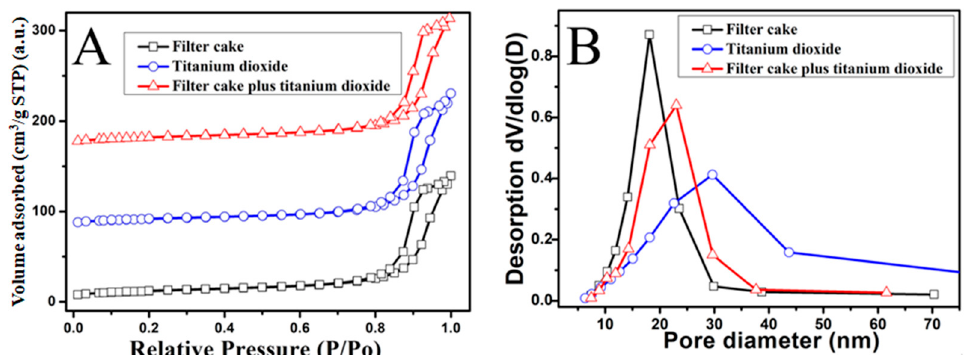
Figure 5. The N 2 adsorption–desorption isotherms curves ( A ) and the corresponding pore size distributions calculated from the desorption branch ( B ) for honeycomb catalysts produced by different titanium sources. Table 2. Summary of the BET data for the honeycomb catalysts produced by different titanium sources.